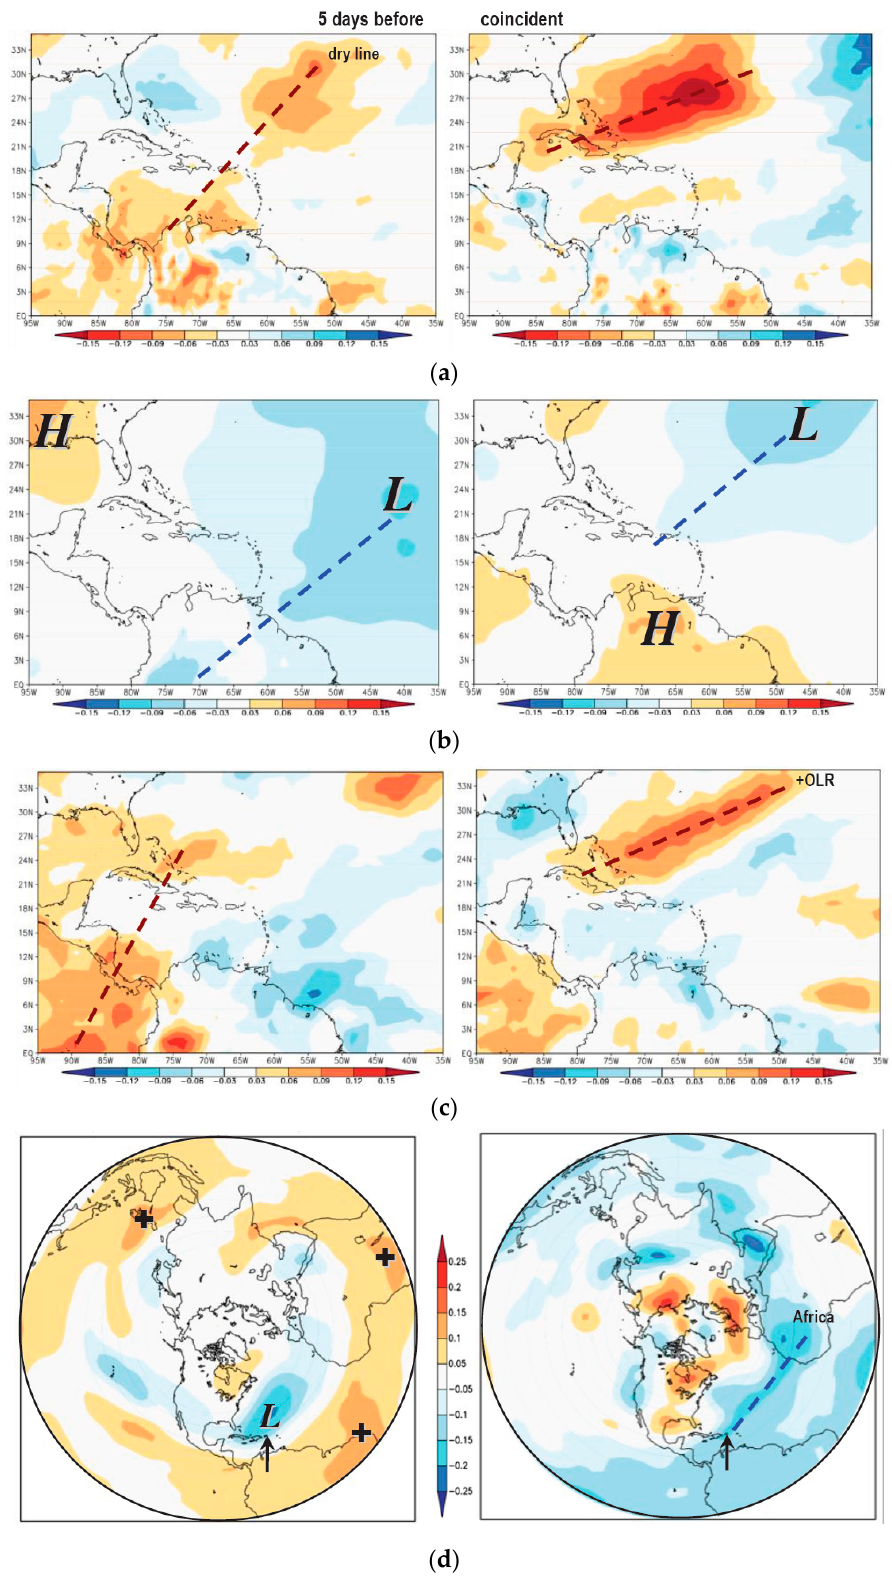
Figure 6. Correlation maps of daily December–May Puerto Rico air index >0.8 with respect to: ( a ) Tdew, ( b ) SL air pressure and ( c ) satellite OLR, N = 1430; left = 5 days before, right = coincident; ( d ) N-polar hemispheric correlation maps of daily Puerto Rico air index and 500 hPa geopotential height, left: all index >0.8, right: December–May index >0.8 at five days before; arrow points to Puerto Rico.